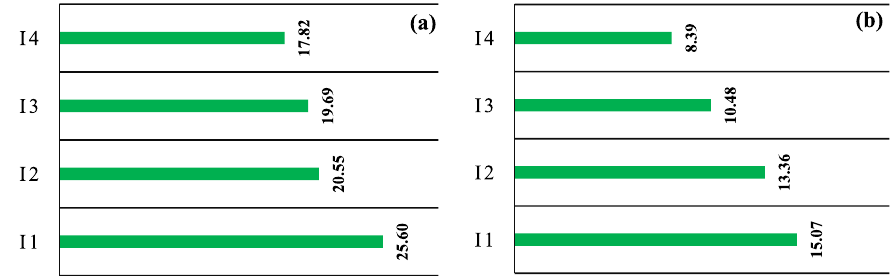
Figure 6. Comparison of mean total phenolics ( a ) and mean flavonoid content ( b ) in black gram seeds in different irrigation